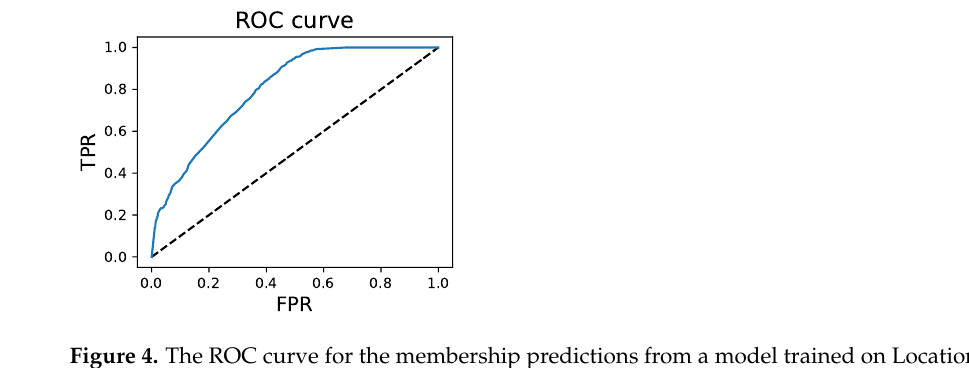
Figure 4. The ROC curve for the membership predictions from a model trained on Location-30 and defended by MemGuard. The AUROC was 0.8, and the TPR was much higher than the FPR in the low FPR regime.